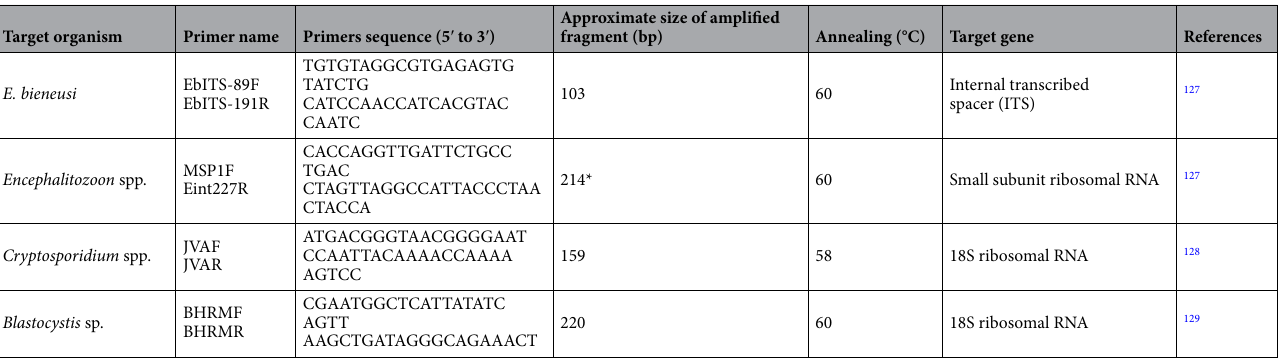
Table 8. Primers used in this study. *The fragment size is different regarding the